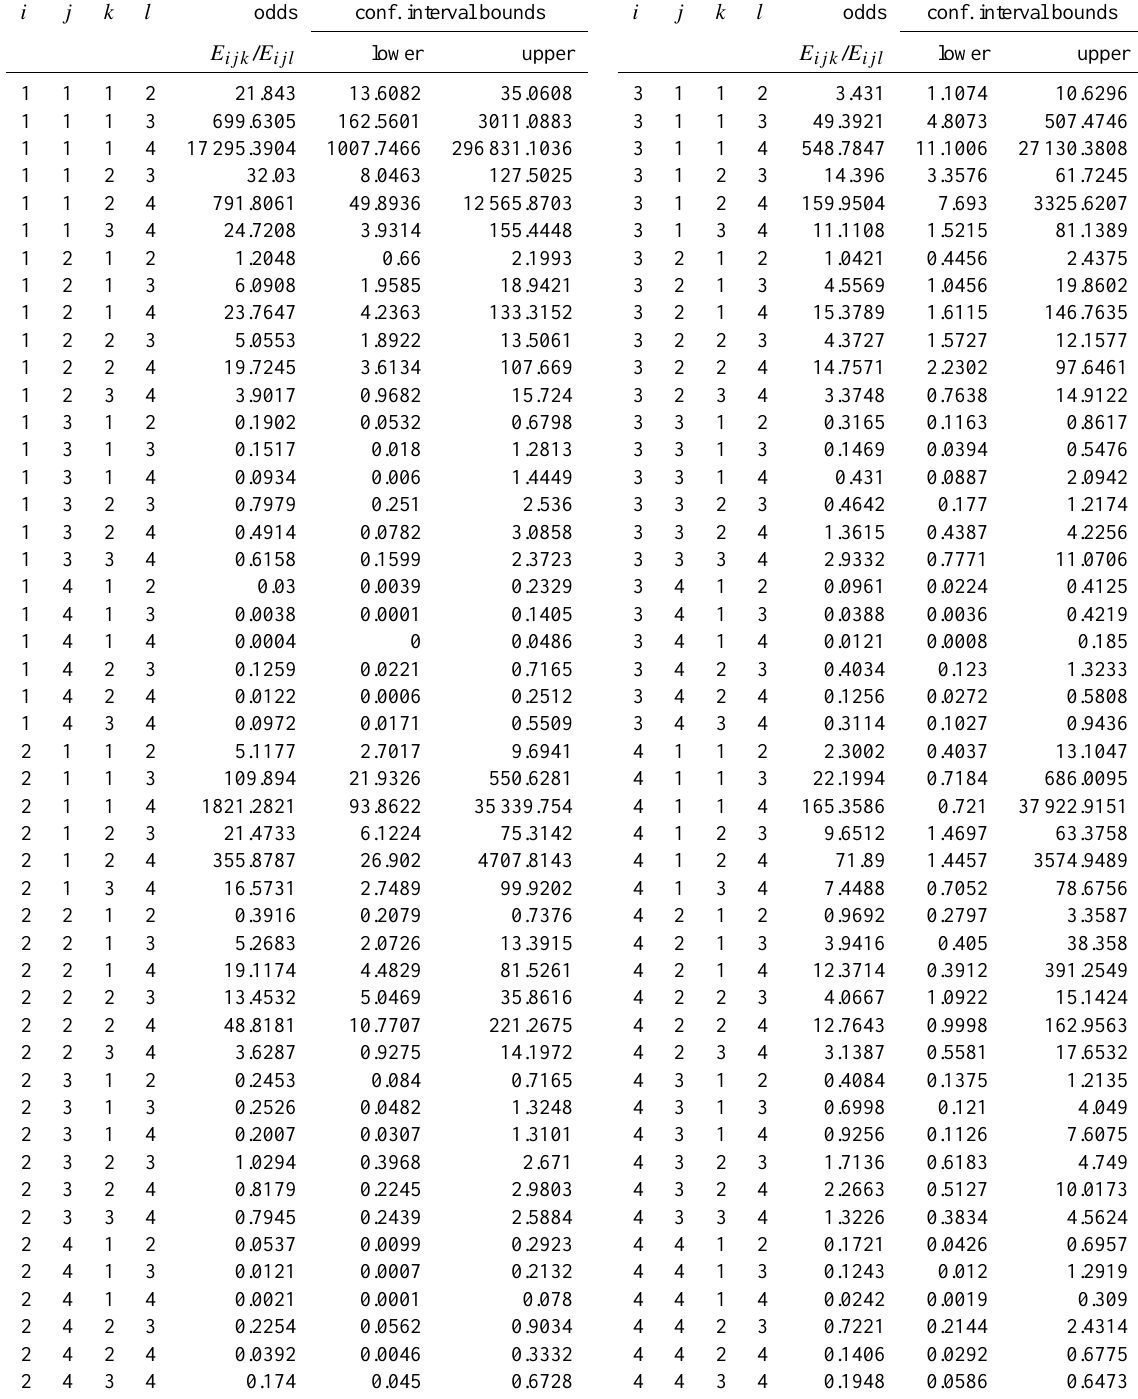
Table 10. Odds and respective confidence intervals for the Aison River